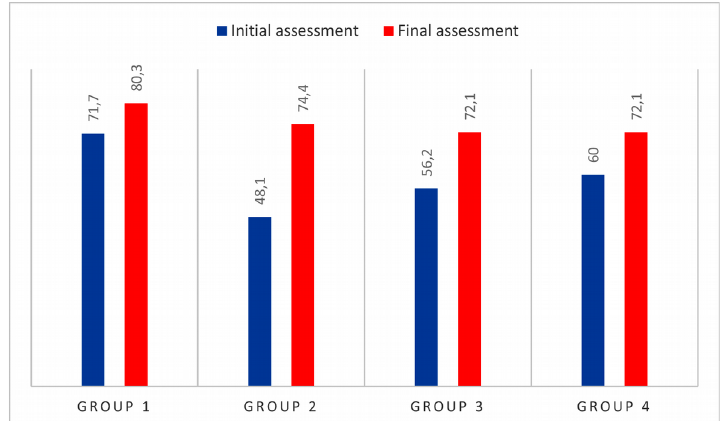
Figure 2. Results of the initial and final assessment of the